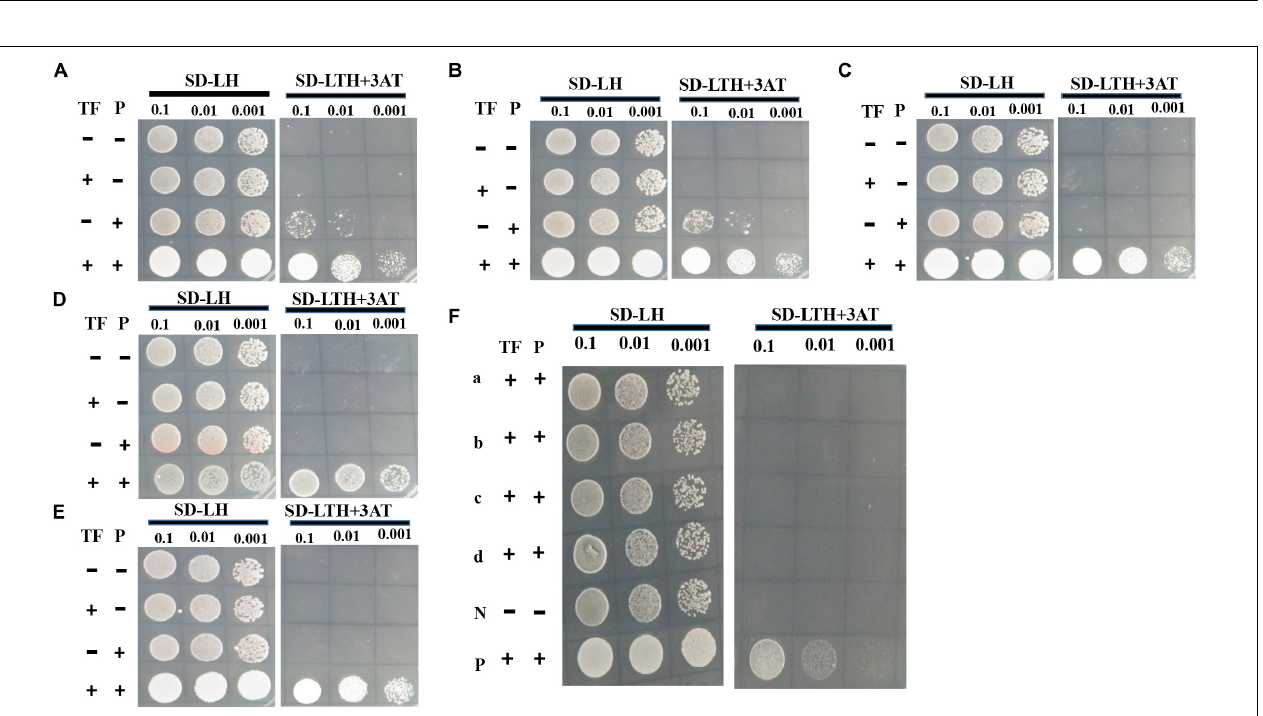
FIGURE 9 | VpFSTF1 (TF) binding activity test using yeast one-hybrid (Y1H) assays. Genes were selected from PHI analysis. (A) VP1G_08357, Pisatin demethylase, (B) VP1G_05619, trichodiene oxygenase, (C) VP1G_02119, oxalate-CoA ligase, (D) VP1G_01209, catalase-related peroxidase, and (E) VP1G_09108, fumitremorgin C monooxygenase. (F) (a) VP1G_02904, TOX, (b) VP1G_08741, isotrichodermin C-15 hydroxylase, (c) VP1G_06375, MFS transporter, and (d) VP1G_02838, NPP1. Yeast transformants were grown on SD/-Leu/His (SD-2) and selected on SD/-Trp/-Leu/-His (SD-3 + 3AT). The plasmid pGADT7 VpFSTF1 (AD- VpFSTF1 , TF) and pHIS2 (P) plasmids containing each promoter of the above genes were cotransformed into the yeast AH109 Gold. The positive control strain contains 53 m: pGADT7, and p53:pHis, AD-empty (–) and BD-empty (–) plasmids were used as negative controls. Yeast transformants were grown on SD/-Leu/His (SD-2) and selected on SD/-Trp/-Leu/-His (SD-3 + 3AT). The plasmid pGADT7 VpFSTF1 (AD- VpFSTF1 , TF) and pHIS2 (P) plasmids containing each promoter of the above genes were co-transformed into the yeast AH109 Gold. AD-empty (–) and BD-empty (–) plasmids were used as negative controls. The cultures were diluted to 1–10 − 3 by 10-fold gradient dilution (OD 600 = 0.5). Cultures were diluted to 1–10 − 3 by 10-fold gradient dilution (OD 600 = 0.5). The results were obtained after 3 days of growth at 28 ◦ C, and typical images were taken.